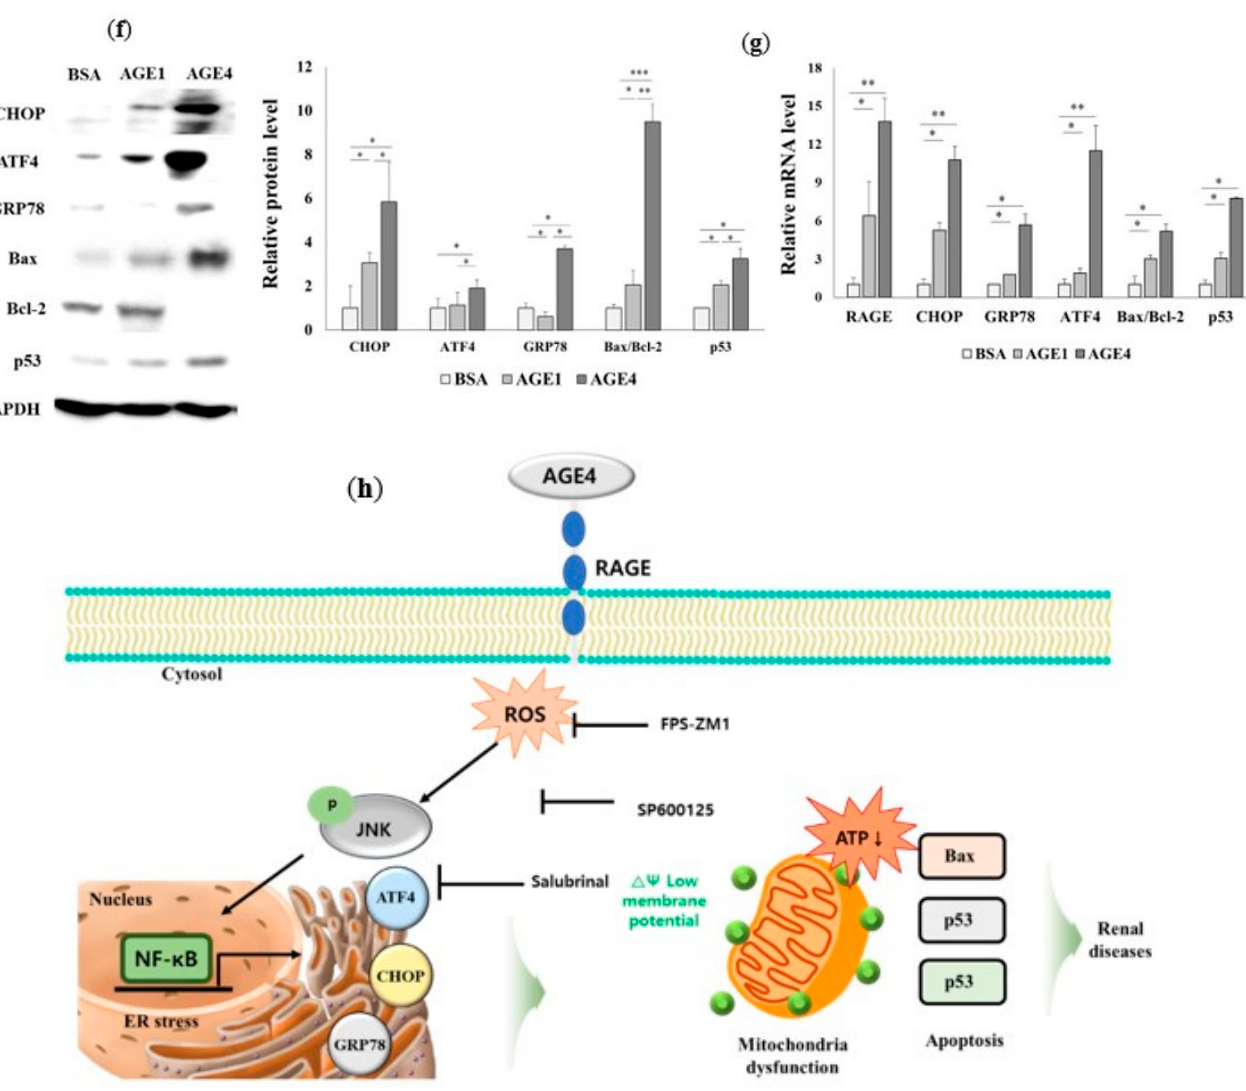
Figure 7. Effects of AGE4 on kidney cell apoptosis in an animal model. The kidney tissue was isolated, and the expression of each marker was determined using Western blot and q-RT-PCR. ( a–c ) The protein expression levels of RAGE, c-Jun, JNK, ERK, P38, and cyclin D1 were detected by Western blot. ( d ) NF- κ B translocation is represented by an increase in nucleus/cytoplasm ratio of its staining in mouse kidneys. ( e ) The protein levels of CHOP, GRP78, ATF4, Bax/Bcl-2, and p53 were detected by Western blot. Densitometric analysis was performed using ImageJ, and the target protein to GAPDH ratio was calculated. ( f ) The mRNA expression levels of RAGE, CHOP, ATF4, GRP78, Bax/ Bcl-2, and p53 were measured by q-RT-PCR. ( g ) A schematic diagram of the influence of the AGE4-induced signal pathway on the endoplasmic reticulum (ER) and mitochondria in the kidney. ( h )AGE4: methylglyoxal-derived AGEs, RAGE: receptors for advanced glycation end products, ROS: reactive oxygen species. * p < 0.05, ** p < 0.01, and *** p < 0.001; groups were compared by t -test.